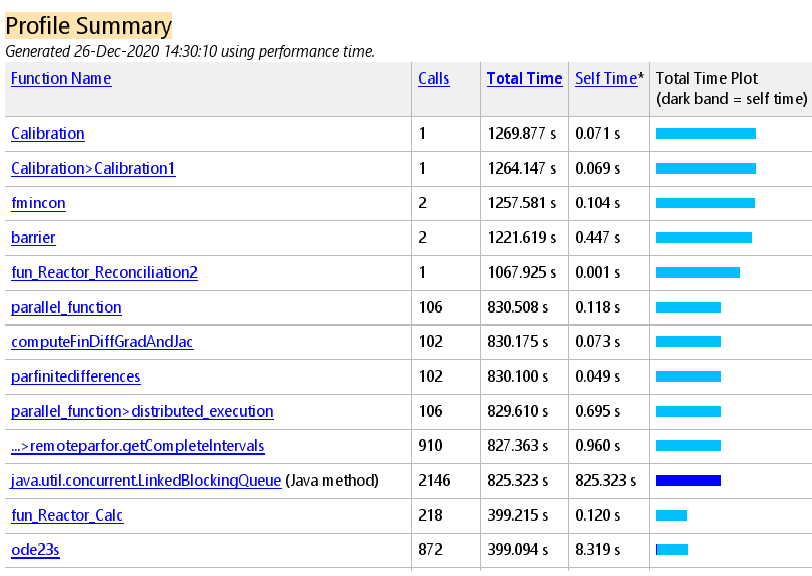
Figure 3. The time taken by some procedures using the sequential method.